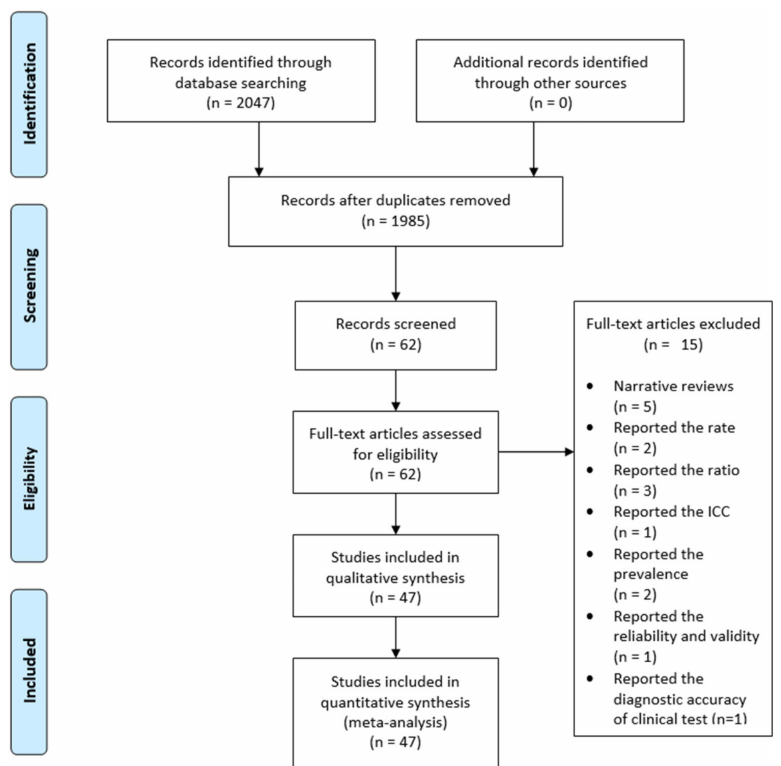
Figure 1. Flow chart describing the selection of the 47 articles after multiple phases of the screening process. ICC, intra-class